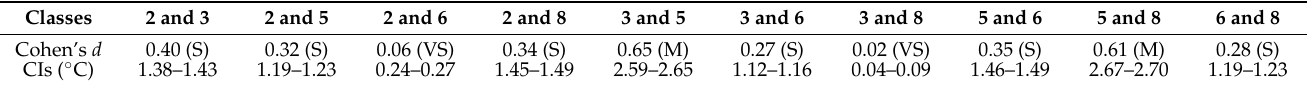
Table 6. Cohen’s d (size effect) and 95% Cis for LST difference between each pair of artificial classes. The letters in parenthesis indicate the corresponding effect size: Negligible (N), Very small (VS), Small (S), Medium (M), Large (L), Very large